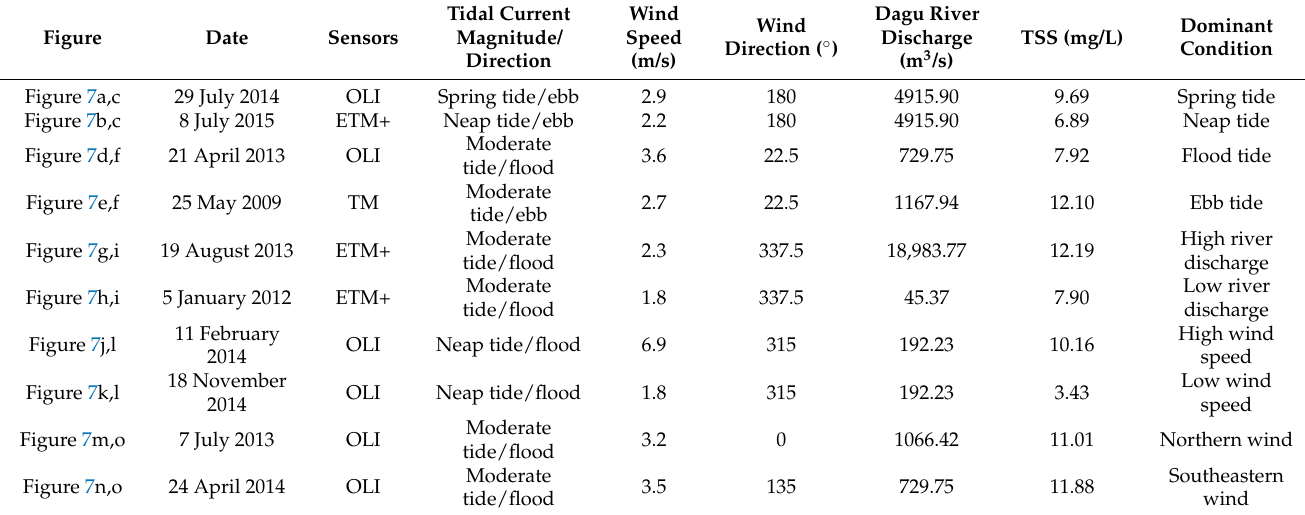
The TSSs near the shore during the spring tide were 2–10 times greater than those during the neap tide (Figure 7a–c). This is because the driving force of the spring tide was much greater than that of the neap tide, and the resuspension effect of the nearshore sediment was intense. Due to the decrease in the water level during the ebb tide, the high reflectance of the sediment in the coastal waters led to the high concentration of TSSs in the coastal waters (Figure 7e). The influx of clear water outside the bay during the flood tide resulted in a slight decrease in the TSSs in the bay (Figure 7d,f). The high river discharge caused 2–3 times more TSSs in the estuary than the low river discharge (Figure 7i). Compared to a slow wind speed (1.8 m/s on 18 November 2014), a fast wind speed (6.9 m/s of 2 November 2014) resulted in strong sea waves and increased TSSs, especially in shallow coastal waters (Figure 7j–l). The TSS concentration was also influenced by the monsoon climatic characteristics. As shown in Figure 7m,n, a southeastern wind caused more sediments to resuspend in the shallow coastal waters than a northern wind (Figure 7o), but in terms of the average TSSs, the difference between the two was not obvious. Therefore, the wind speed was a meteorological factor that affected the distribution of TSSs in JZB more than the wind